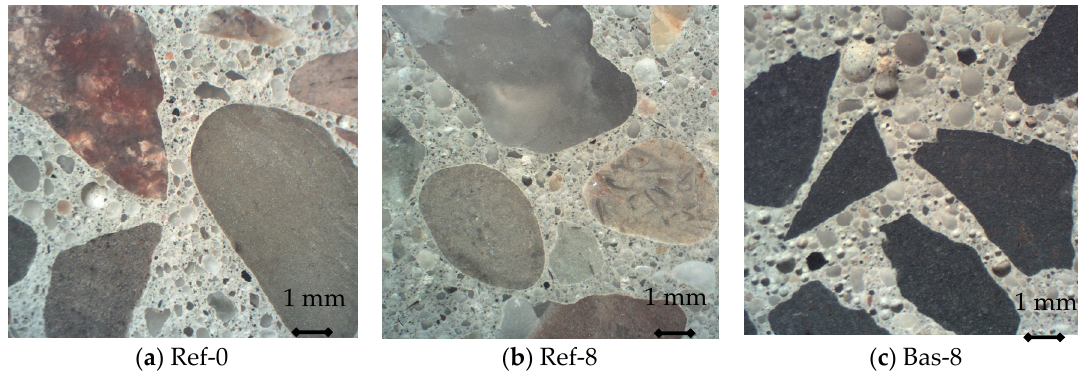
Figure 1. Cross-sections of specimens.